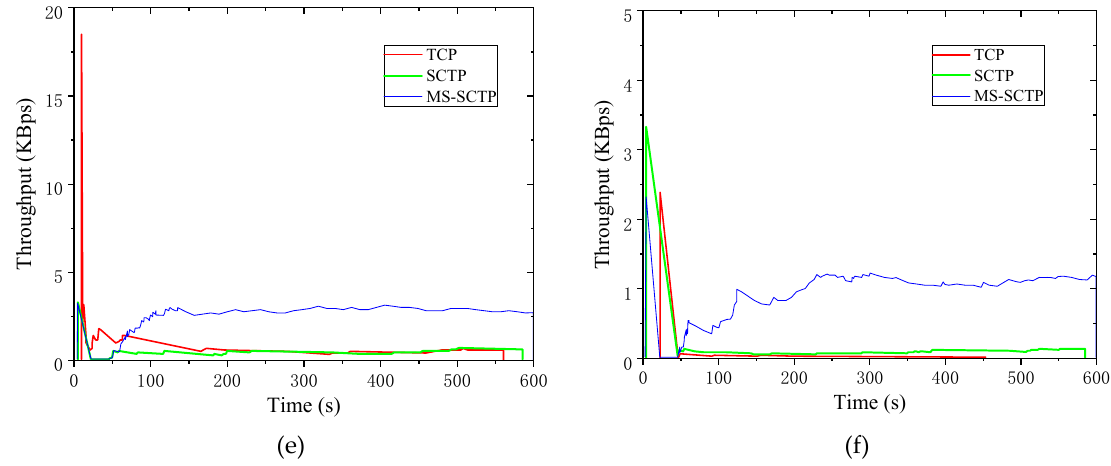
Figure 7. Real-time throughput comparison when the error rate was 0–50%. ( a ) PER: 0%; ( b ) PER: 10%; ( c ) PER: 20%; ( d ) PER: 30%; ( e ) PER: 40%; ( f ) PER: 50%.